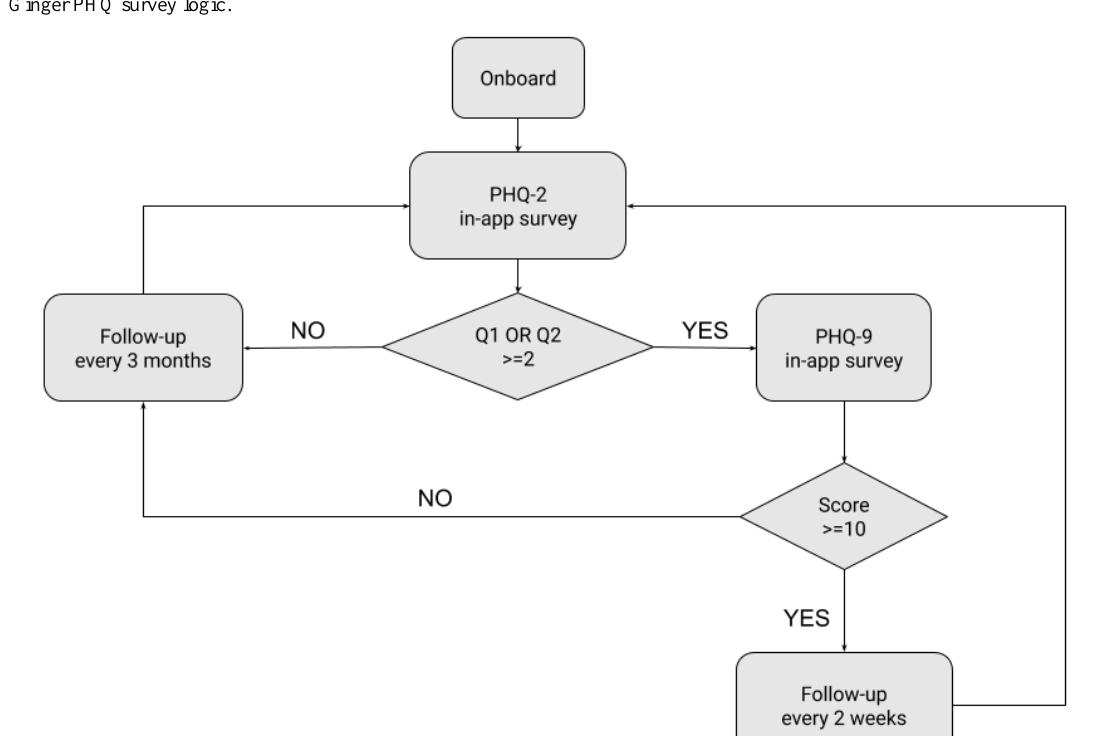
Figure 3. Ginger PHQ survey